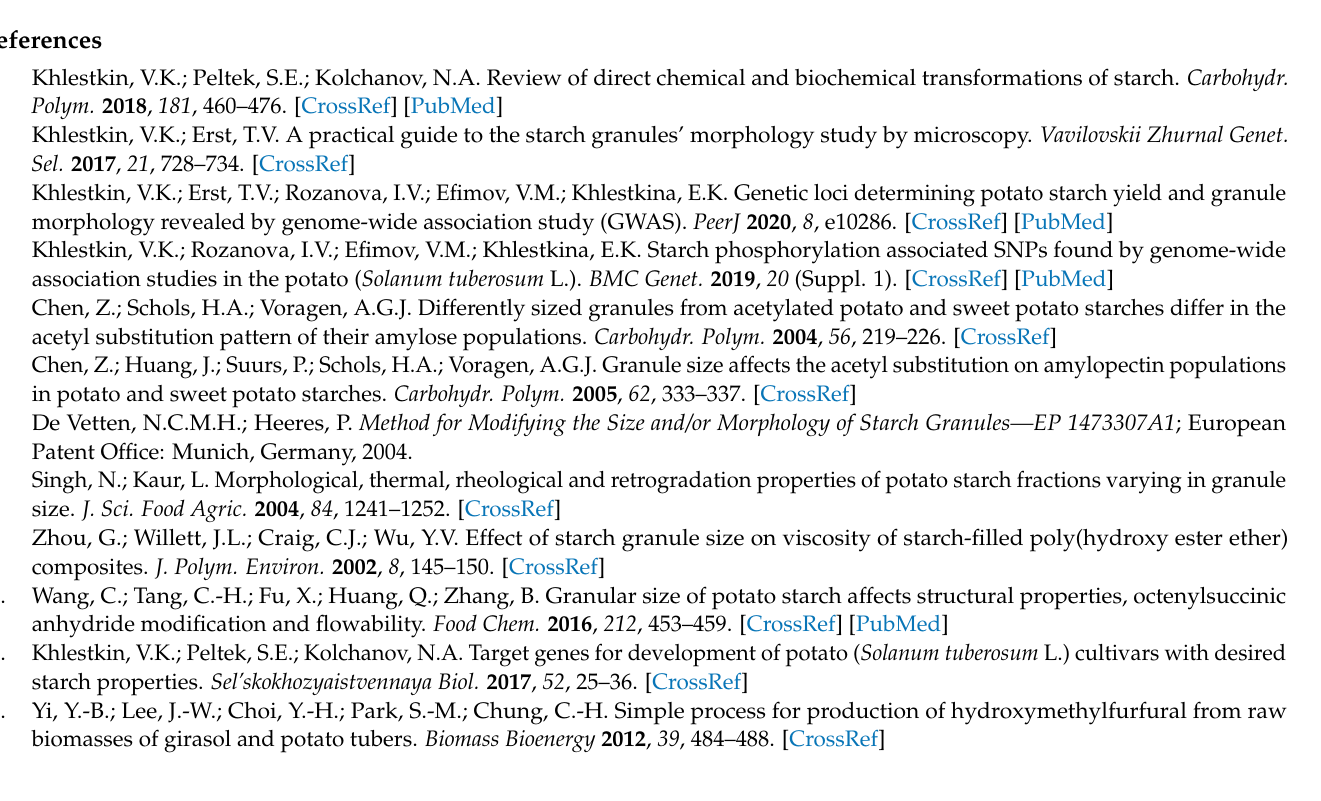
Supplementary Materials: Figure S1: 1H-NMR spectra of levulinic acid, Figure S2: 1H-NMR spectra